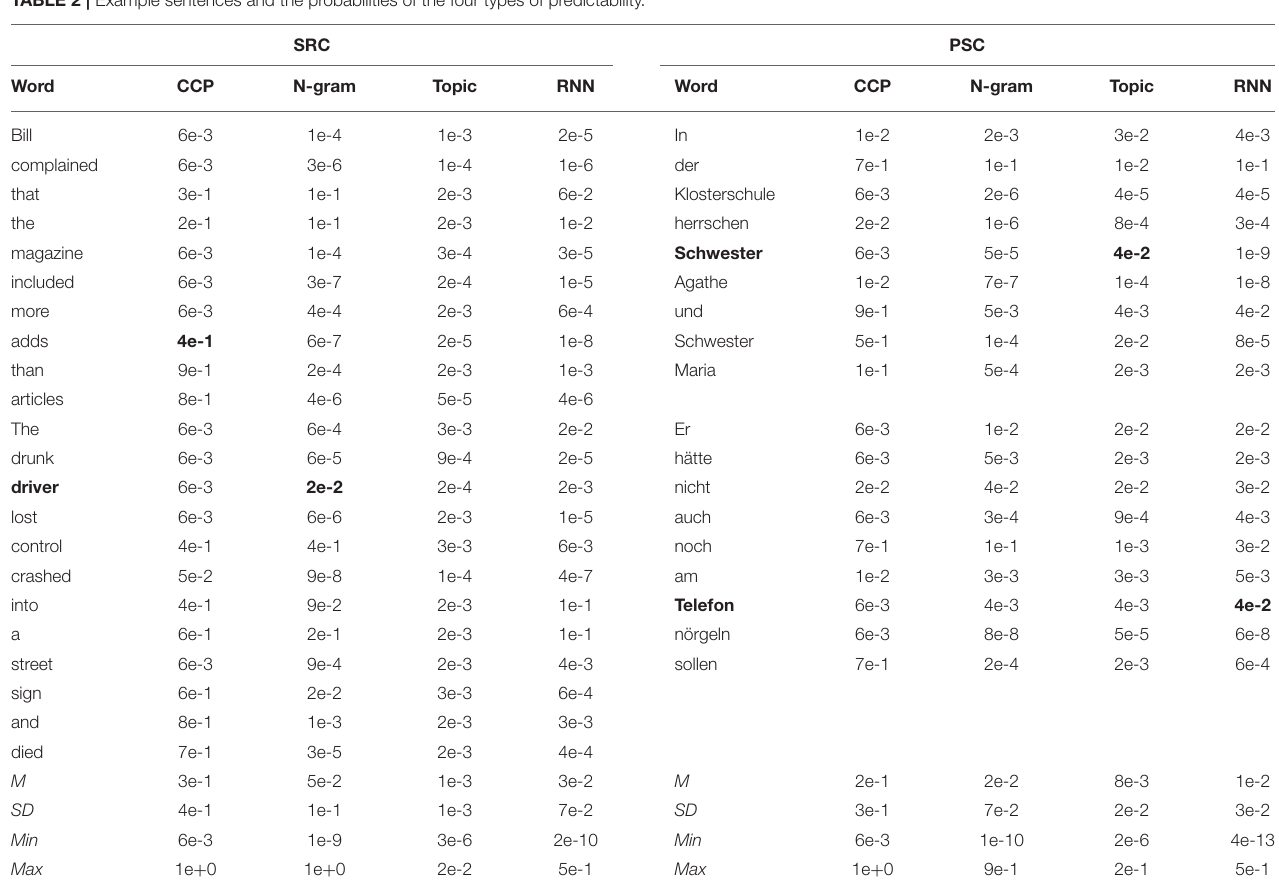
TABLE 2 | Example sentences and the probabilities of the four types of